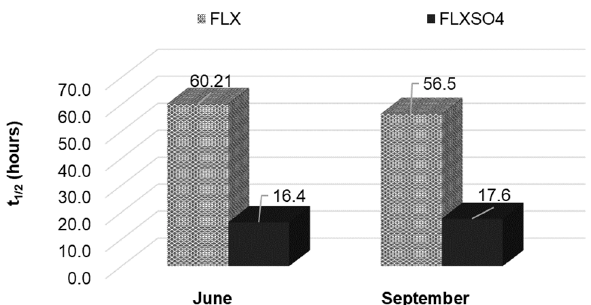
Figure 4. Predicted variation of ANT half-life times in the Guarapiranga Reservoir in June and September 2021.